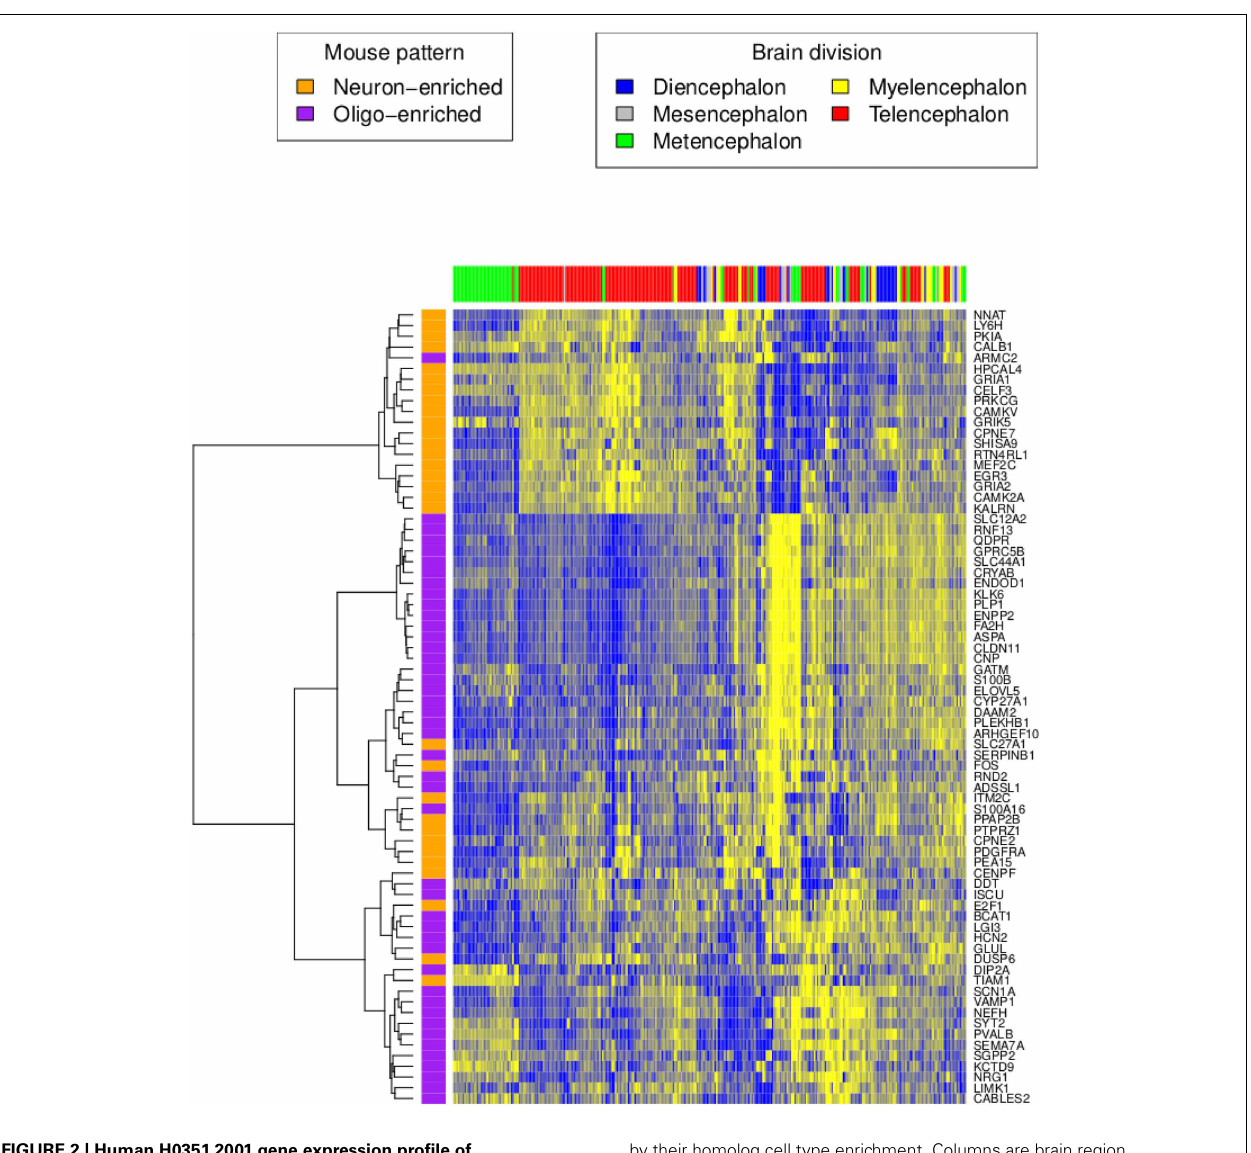
FIGURE 2 | Human H0351.2001 gene expression profile of orthologous genes reported in the mouse neuron and oligodendrocyte-enriched patterns. High and low expression levels are colored in yellow and blue respectively. Rows are genes colored